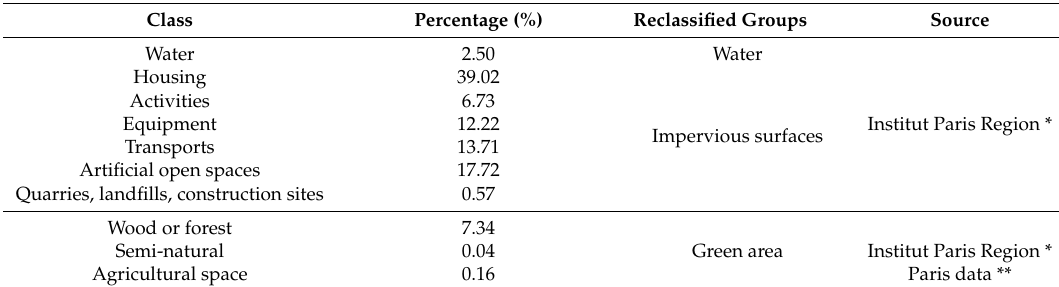
Table 2. Land cover classification in